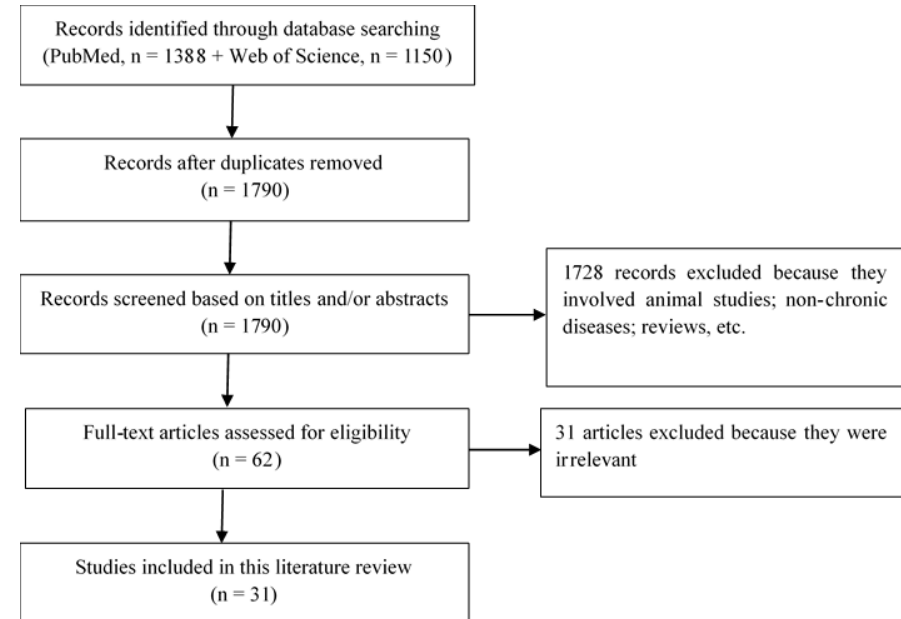
Figure 1. Selection flow-chart of the studies included in the